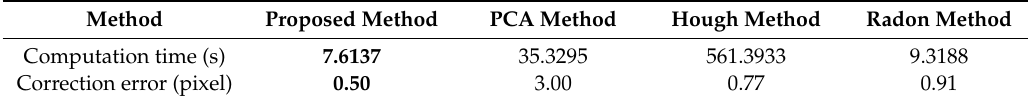
Table 7. Comparison of results of the four